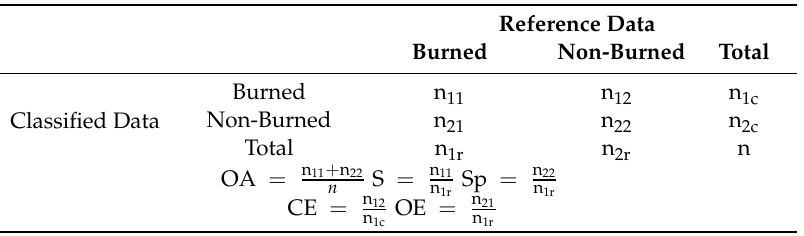
Table 2. Confusion matrix of a binary classification of burned area and the main metrics derived from it. OA, overall accuracy; S, sensibility or producer’s accuracy; Sp, specificity; CE, commission error; OE, omission